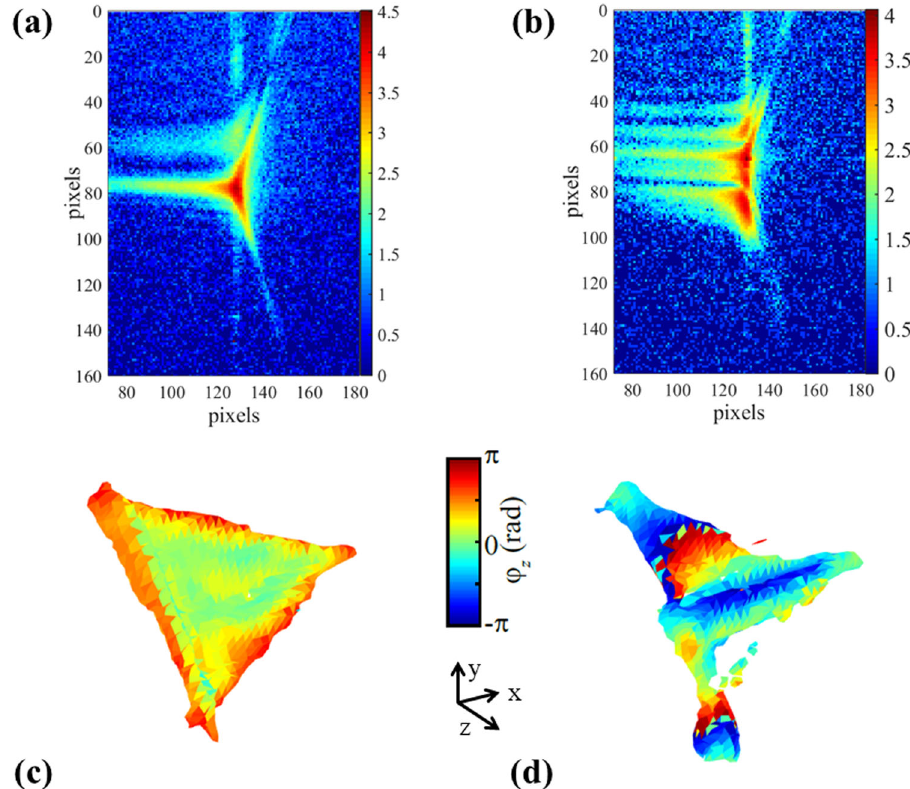
Fig. 4 BCDI of microstructures with less uniform strain distribution obtained with 5- µ m-side triangular HM. a , b XRD patterns taken at the peak of the [004] GaAs 1 − y N y rocking curve. c , d Relative reconstructed phase maps represented by the phase values that intersect the amplitude isosurfaces equal to 40% and 30% of the amplitude maximum, respectively. Intensity color map of the XRD patterns has logarithm scale given as power of 10, phases have radians units. Resolution of the reconstructed images is about 83 and 90 nm, respectively; pixel size is 72 nm. Note that the XRD patterns are differently oriented with respect to the one of Fig. 2a due to a different orientation of the micro-triangles with respect to the x-ray beam. In the Cartesian axis representation “ z ” indicates the vertical direction, “ y ” the direction of the x-ray beam, “ x ” the direction transverse to the beam. The full 3D reconstructed complex density functions for the two microstructures are available upon request from the authors as Matlab data fi